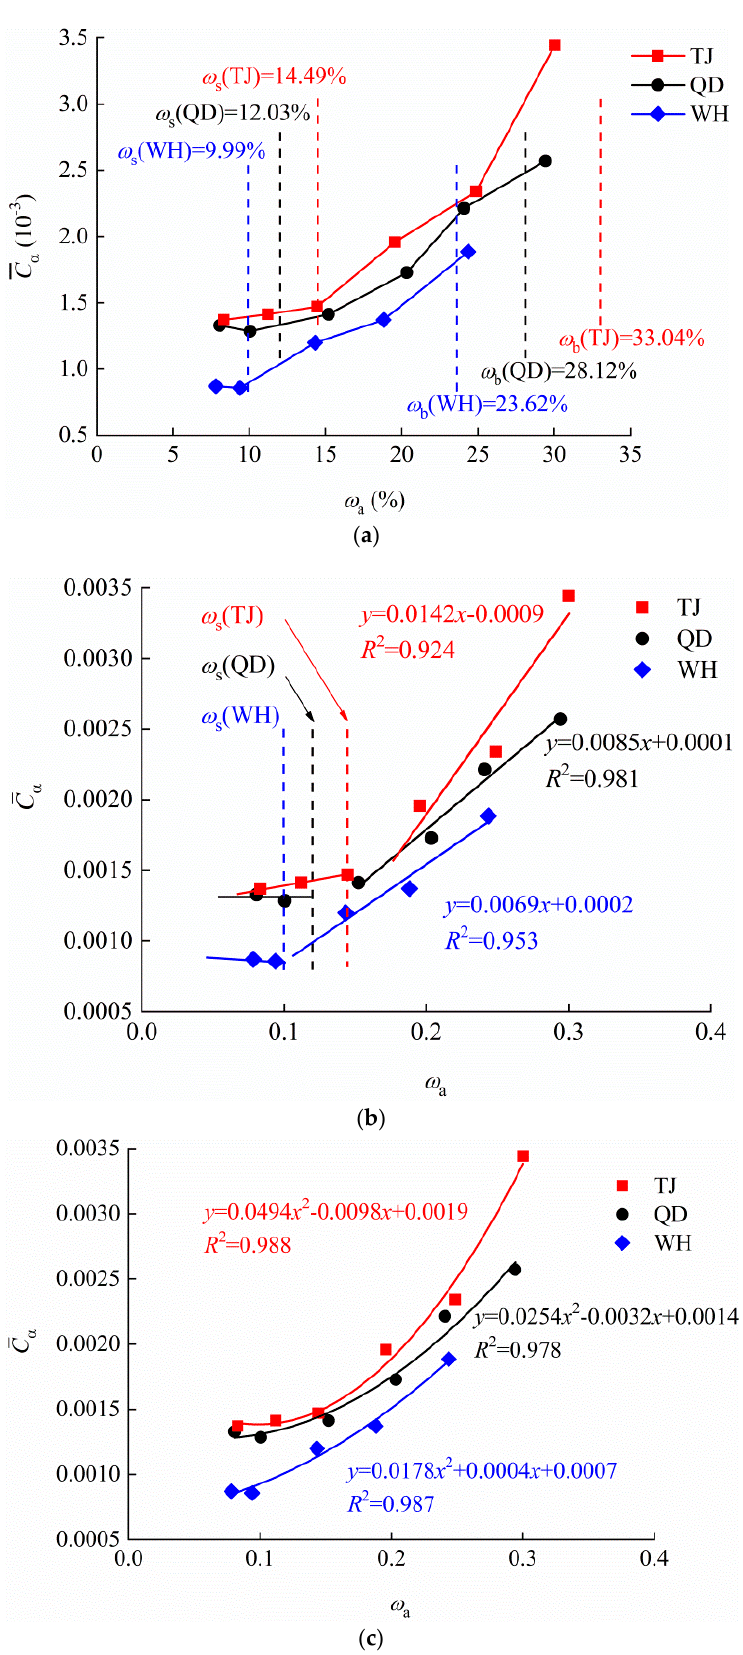
Figure 7. Relationship of C α with ω a : ( a ) C α – ω a curves and boundary water contents; ( b ) piecewise linear fitting; ( c ) secondary polynomial fitting.